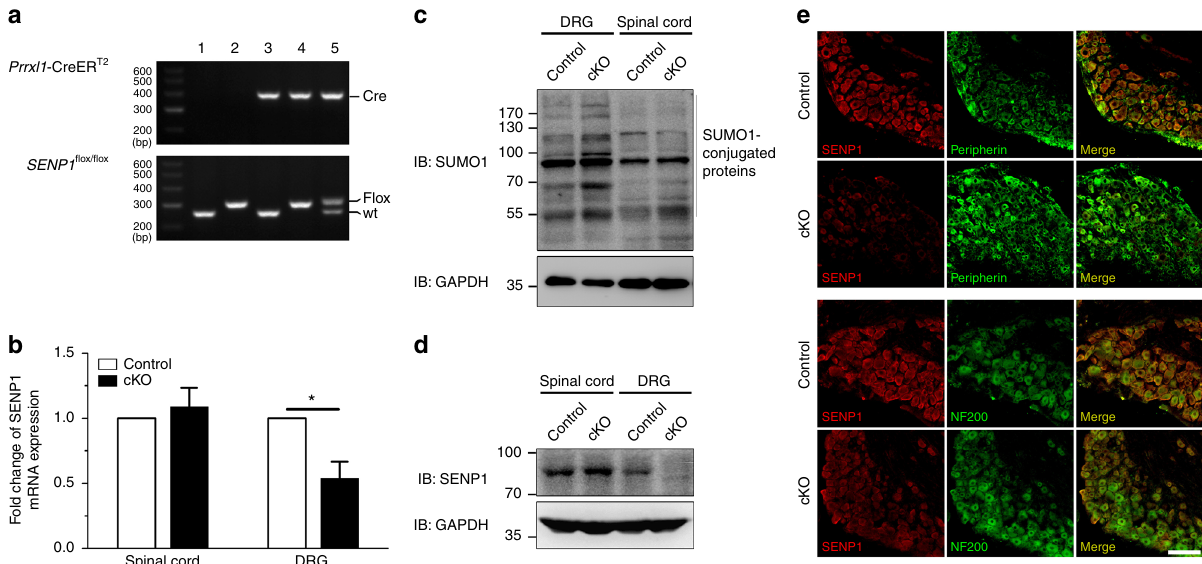
Fig. 2 Generation of primary somatosensory neuron-speci fi c SENP1 cKO mice. a PCR analysis of genomic DNA obtained from DRG of SENP1 fl ox/ fl ox and Prrxl1 -CreER T2 intercrosses. Line 1, wild type; line 2, SENP1 fl ox/ fl ox (Control); line 3, Prrxl1 -Cre ER T2 ; line 4, SENP1 fl ox/ fl ox ; Prrxl1 -Cre ER T2 ( SENP1 cKO); line 5, SENP1 wt / fl ox ; Prrxl1 -Cre ER T2 . b SENP1 mRNA was reduced in DRG of SENP1 cKO mice. Real-time qPCR was used to determine the SENP1 mRNA levels in the DRG and spinal cord from SENP1 cKO and its littermate control mice 4 weeks after tamoxifen administration. Data are mean ± s.e.m. normalized to that of the control from three independent experiments. P = 0.0227, Control DRG vs. cKO DRG by Student ’ s t test. c SUMO1-conjugated proteins were increased in DRG, but not spinal cord, of SENP1 cKO mice. DRG and spinal cord were dissected from SENP1 cKO and their littermate control mice and analyzed by western blotting using anti-SUMO1 and anti-GAPDH antibodies. d SENP1 protein level was decreased in SENP1 cKO DRG compared to its littermate controls. DRG and spinal cord were dissected from SENP1 cKO and their littermate control mice and analyzed by western blotting using anti-SENP1 and anti-GAPDH antibodies. e Veri fi cation of SENP1 gene deletion in DRG of SENP1 cKO mice by immunohistochemistry, with double staining for SENP1 (red) and peripherin (green) or NF200 (green) for DRG sections from SENP1 cKO mice (lower) and its littermate controls (upper). Scale bar: 100 μ